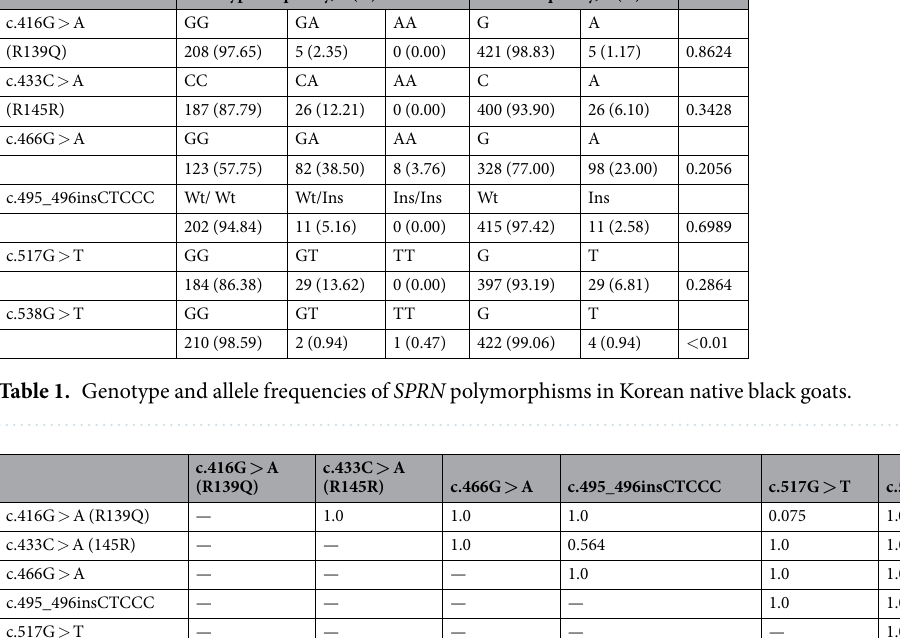
— — — — Table 2. Linkage disequilibrium (LD) of six SPRN polymorphisms in Korean native black goats.